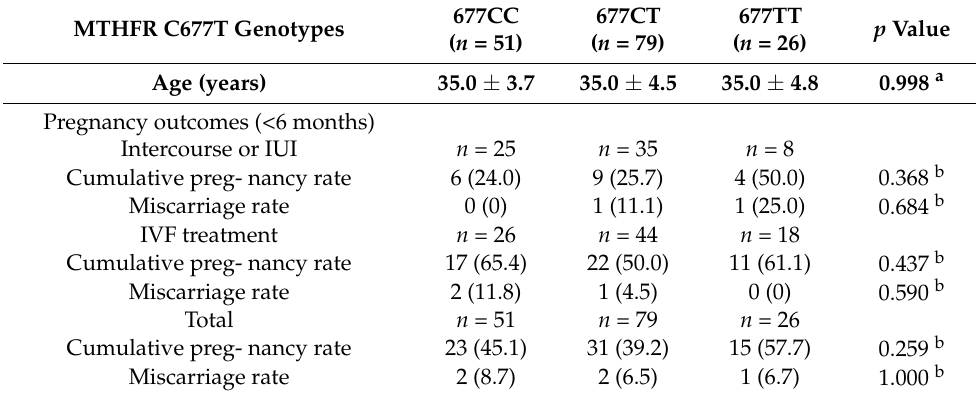
Table 3. Pregnancy